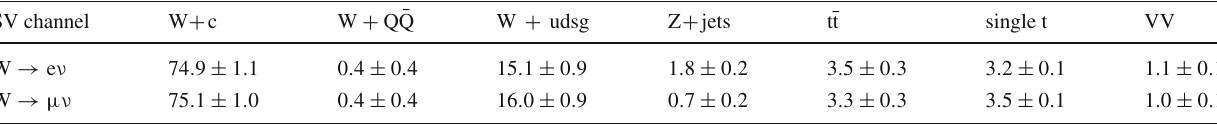
Table 3 Simulated flavour composition (in %) of the SV sample after the selection summarized in Table 1, including OS–SS subtraction, for the electron and muon W boson decay channels. W + Q ¯ Q is the sum